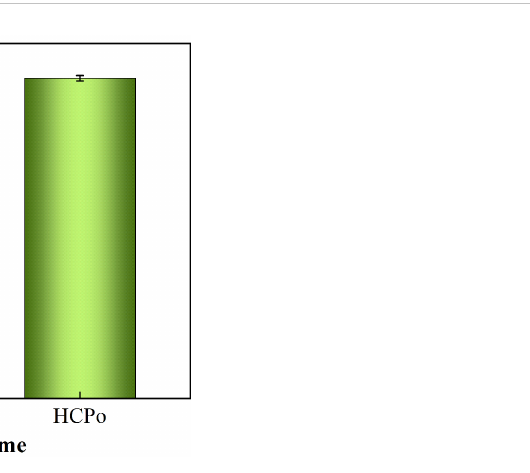
FIGURE 1 The ergosterol content in two types of media. Notes: HCBe, bean media; HCPo, potato dextrose